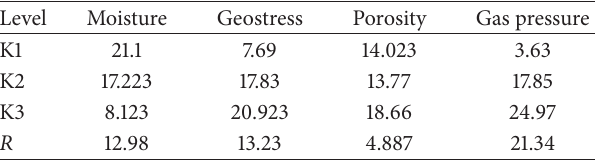
Table 5: Range analysis and the result.